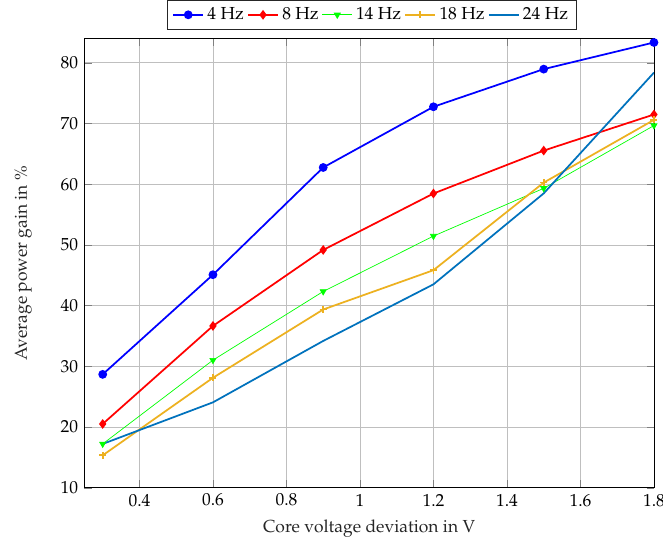
Figure 14. Power